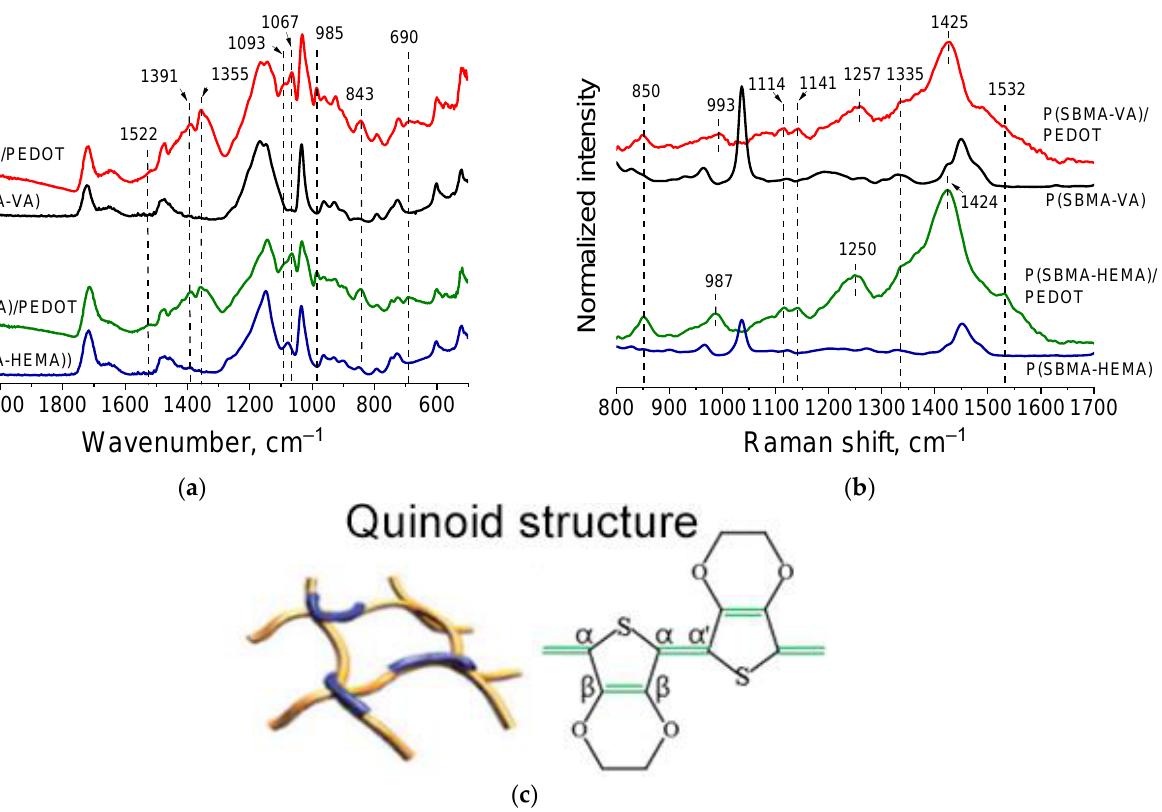
Figure 6. FTIR ( a ) and Raman ( b ) spectra for cryogel complexes with PEDOT; proposed structure of PEDOT in complexes ( c ).